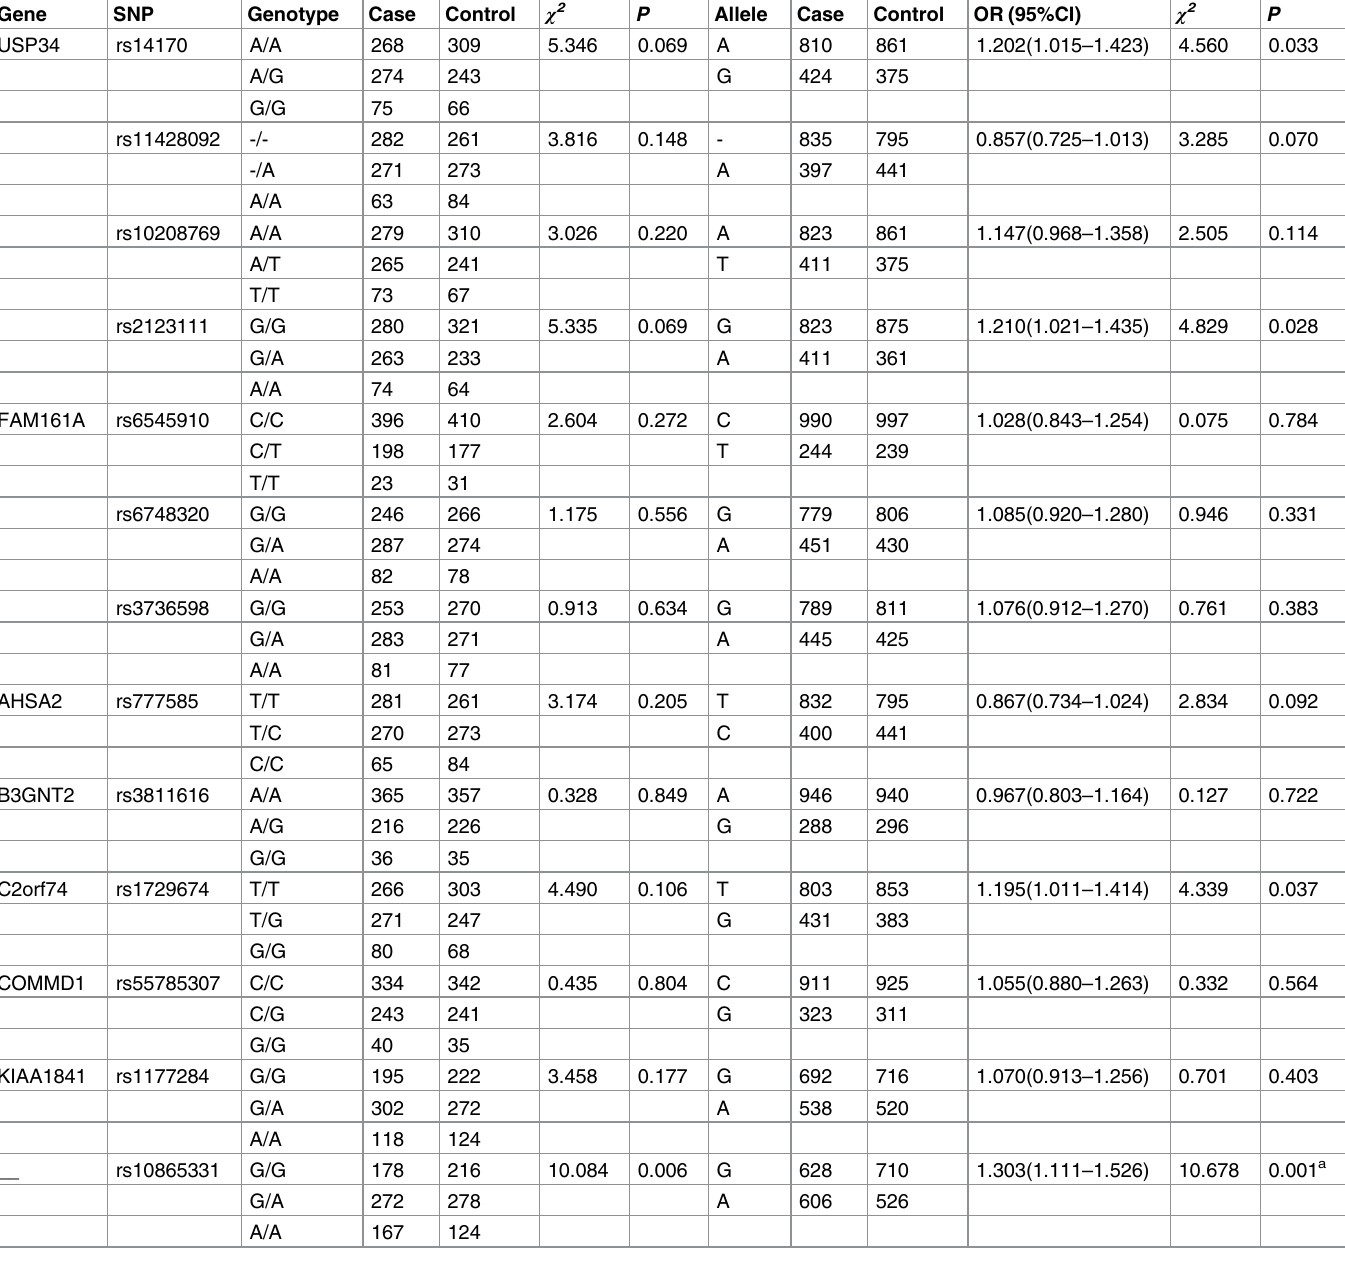
Table 1. The genotype and allele frequencies of identified SNPs in AS cases and healthy controls.